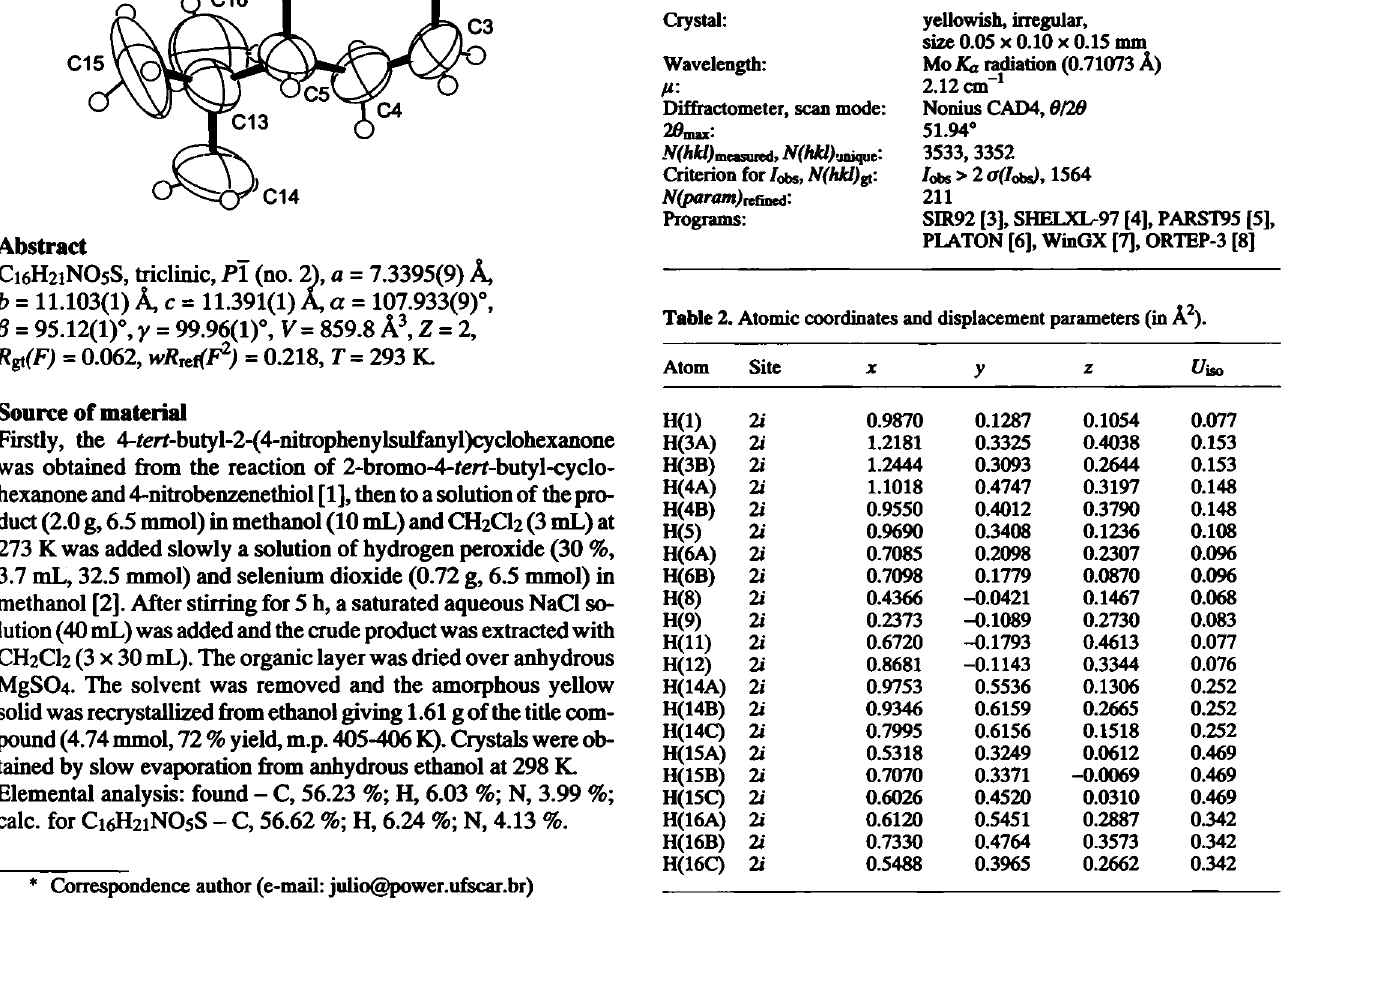
Table 1. Data collection and handling.